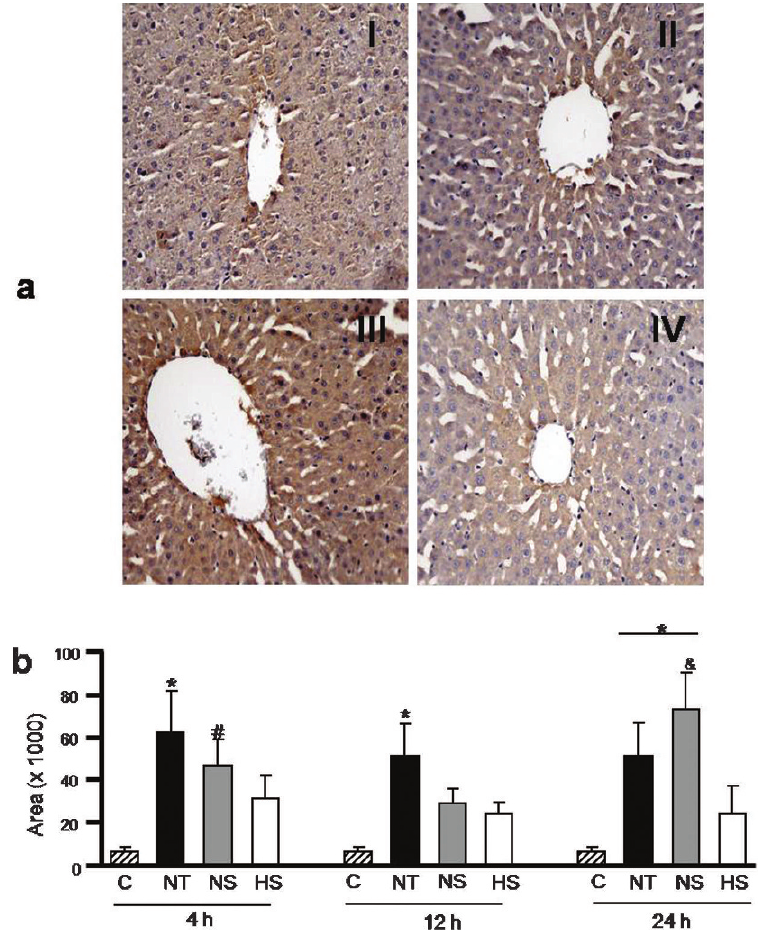
Figure 4 - Nitrotyrosine expression in liver samples (a) from rats in the four groups: control ( I ) NT ( II ), NS ( III ) and HS ( IV ) at 24 h. Nitrotyrosine expression (b) in all groups. Data are the means ¡ SEM, n = 8 in each group. (Original magnification, 6 200). * P , 0.01 vs. C; # P , 0.05 vs. C; & P , 0.05 vs.